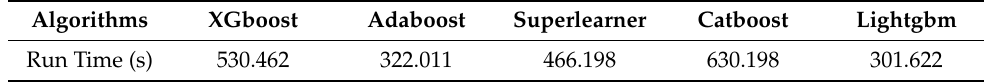
Table 5. The computational cost for the algorithms used in this